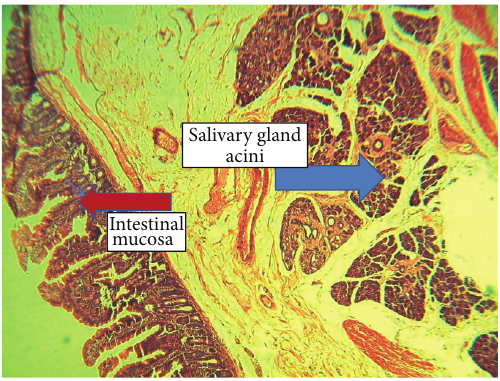
Figure 1: Salivary gland tissue in a background of intestinal